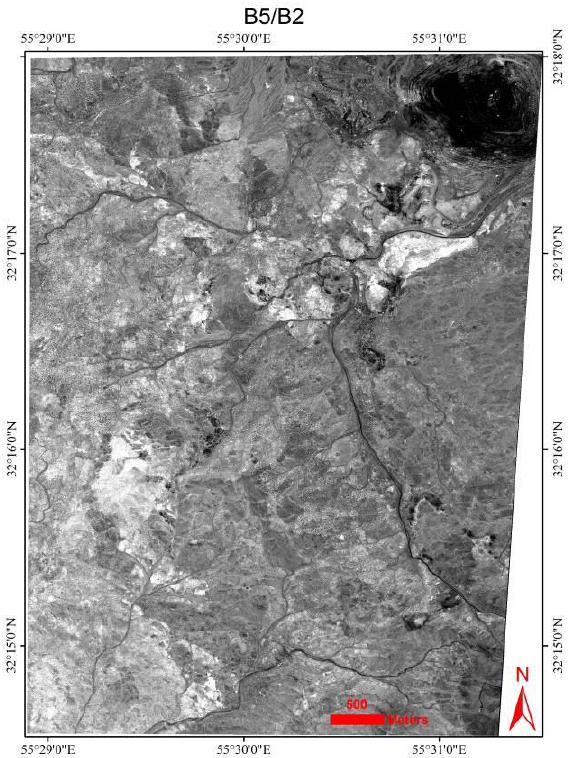
Fig. 4. Band 5/band 2 ratio image of WV-3 data from Chadormalu area, central Iran highlighting ferric iron rich and iron oxide/hydroxides components of desert varnish on the granitic rock